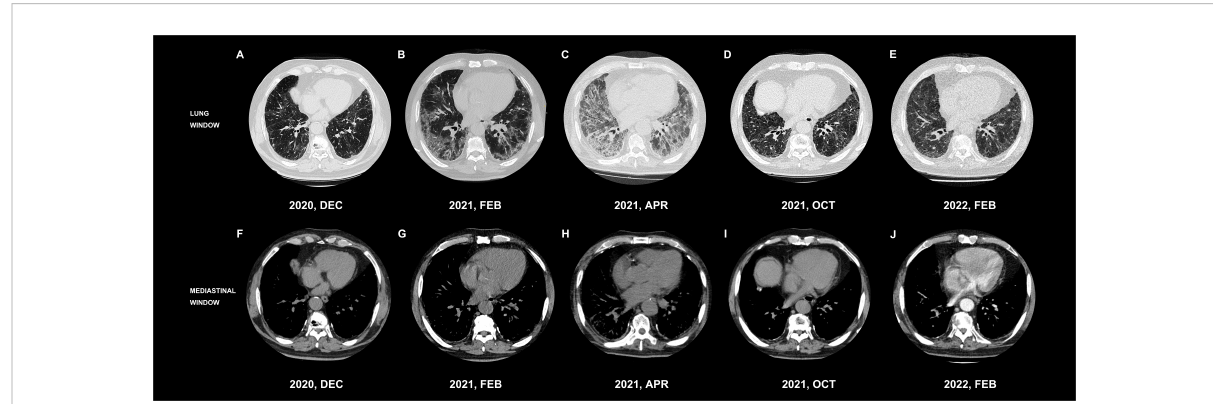
FIGURE 2 Chest CT of inferior lungs in the lung and mediastinum windows. Dynamic changes in the interstitial lesions in the bilateral inferior lobes of the lung. (A) / (F) Mild basic interstitial changes. (B) / (G) Signi fi cant peribronchovascular and subpleural GGOs, reticulation, and consolidation. (C) / (H) Signi fi cant fi brotic with GGOs, reticulation, consolidation, honeycomb shadows, and thickened interlobular septa. (D) / (I) Signi fi cantly improved interstitial changes and better transparency. (E) / (J) Stable mild interstitial